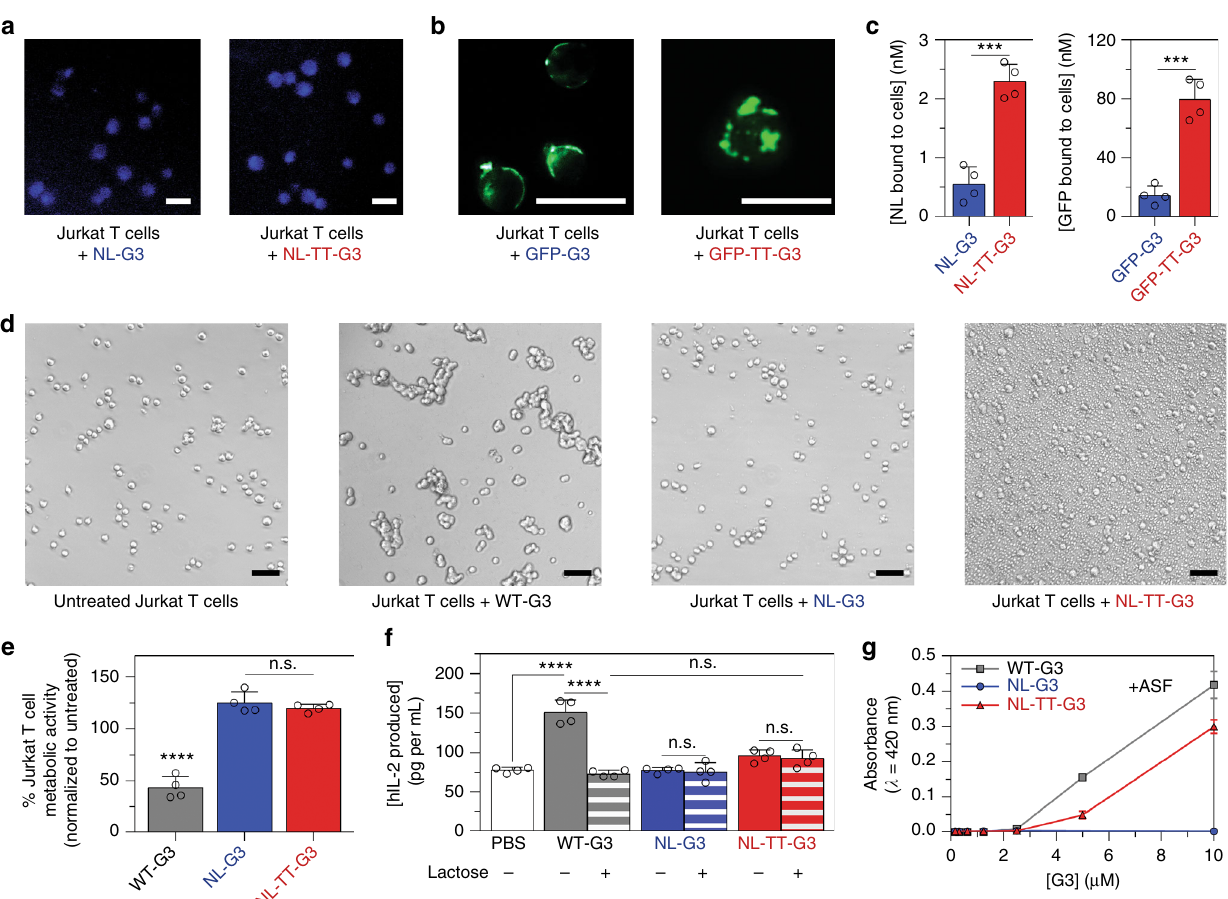
Fig. 4 Extracellular signaling activity of monomeric G3 fusion proteins and trimeric nanoassemblies. a Micrographs demonstrating NL-G3 and NL-TT-G3 bioluminescence on Jurkat T cells using a blue fl uorescence fi lter. b Micrographs demonstrating GFP-G3 and GFP-TT-G3 fl uorescence on Jurkat T cells using a green fl uorescence fi lter. c Amount of NL or GFP bound to Jurkat T cells after 4 h incubation with NL-G3, NL-TT-G3, GFP-G3, or GFP-TT-G3. d Bright- fi eld micrographs of Jurkat T cells incubated with PBS (untreated, negative control), WT-G3 (positive control), NL-G3, or NL-TT-G3 for 4 h. e Percentage of metabolic activity of Jurkat T cells incubated with WT-G3 (positive control), NL-G3, or NL-TT-G3 for 4 h. f hIL-2 produced by Jurkat T cells after incubation with PBS (negative control), WT-G3 (positive control), NL-G3, or NL-TT-G3 for 24 h. Lactose was added as an inhibitor of G3 binding to Jurkat T cells. g Asialofetuin (ASF) (7 µ M) precipitation with various quantities of WT-G3, NL-G3, or NL-TT-G3 as measured by light scattering and absorbance at 420 nm. N = 4, mean ± s.d., *** p < 0.001, Student ’ s t test for c . N = 4, mean ± s.d., n.s. is no signi fi cant differences, **** p < 0.0001, ANOVA with Tukey ’ s post hoc for e and f . N = 3, mean ± s.d. for g . Scale bar = 25 µ m for a , b . Scale bar = 50 µ m for d . Data points at or above baseline signal are shown as open circles in c , e , f . Data for WT-G3 appear as gray bars/squares/traces, for monomeric G3 fusion proteins as blue bars/circles/traces, and